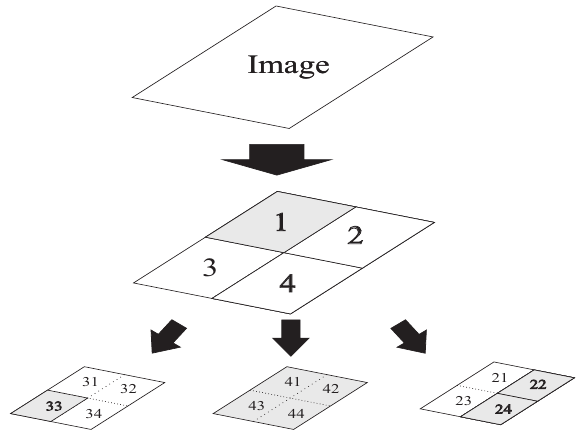
Figure 1 . QTD example in the form of a multilayer set of blocks and a corresponding tree structure.